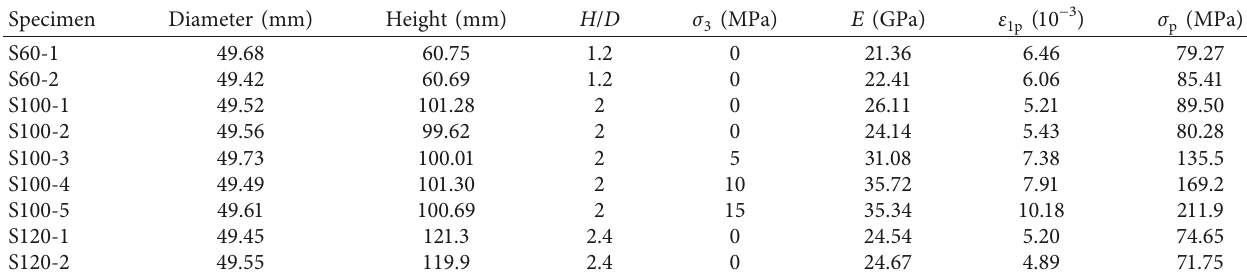
p ), and peak axial strain ( ε 1p ) of the sandstone specimens.